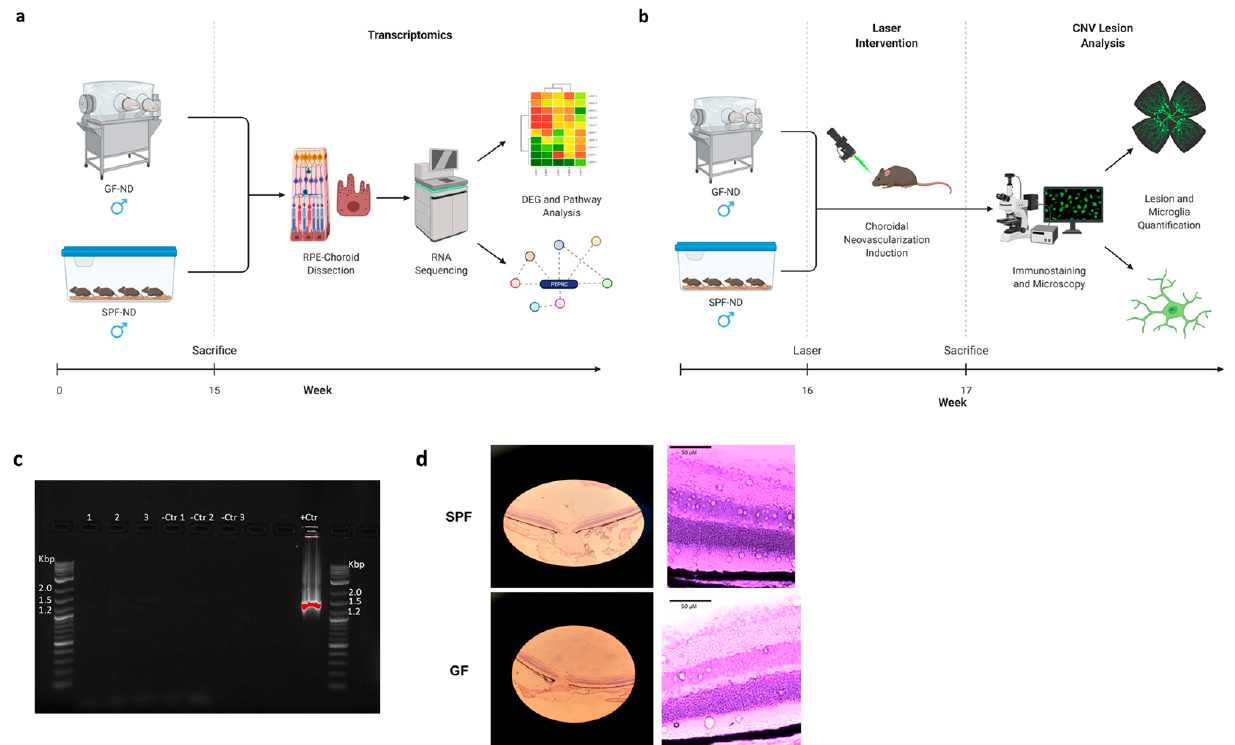
Figure 1. ( a , b ) Schematic diagrams indicating methodology for transcriptomic ( a ) and CNV lesion analysis ( b ) of GF-ND and SPF-ND mice. Images designed with Biorender. ( c ) Sterility of GF-ND mice (1–3) was confirmed by gel electrophoresis of fecal DNA RT-PCR products, with PCR mix and water (Ctr1), water (Ctr2), known negative sample (Ctr3), and known positive sample (+Ctr) as controls. ( d ) SPF-ND and GF-ND mice had similar retinal morphology at baseline as indicated by hematoxylin and eosin (H&E) staining. Scale bar = 50 µ m.